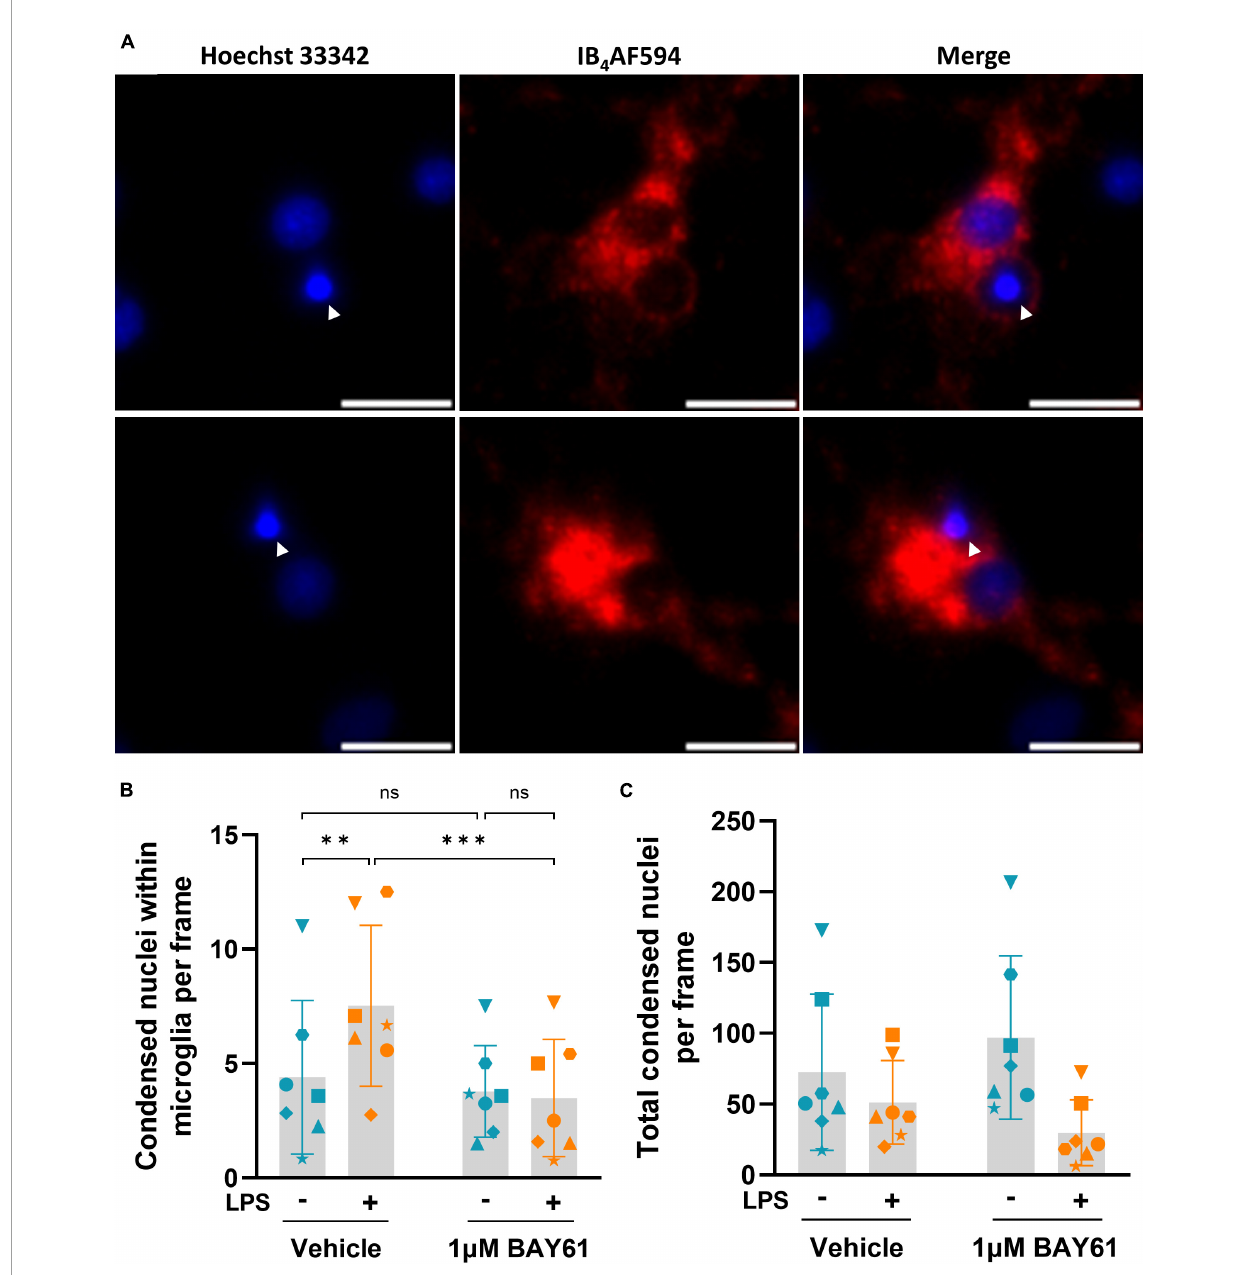
FIGURE7 Syk inhibition prevents LPS-induced phagocytosis of neurons by microglia. (A) Representative fields of view depicting condensed nuclei (Hoechst 33342) within microglial membrane staining (IB 4 -AF594) from DIV7 images of neuron-glia cultures treated with 100 ng/ml LPS for 3 days. Arrowheads indicate condensed nuclei within microglia. Scale bars = 10 µ m. (B) Average counts of condensed nuclei within microglia per image in neuron-glia cultures treated ± BAY61 (1 µ M) and ± LPS (100 ng/ml) for 3 days (DIV10). RM 2-way ANOVA with Šídák’s post-hoc test. (C) Average counts of total condensed nuclei per image in neuron-glia cultures treated ± BAY61 (1 µ M) and ± LPS (100 ng/ml) for 3 days (DIV10). All panels: each datapoint represents the mean of three technical replicates. Number of biological repeats = number of datapoints per column. ∗∗ p < 0.01, ∗∗∗ p <